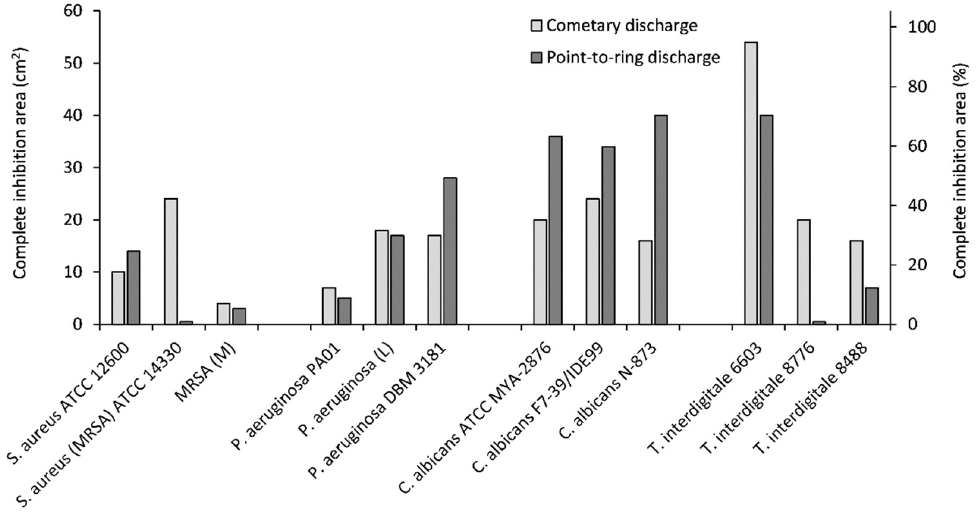
Figure 6. Areas of complete inhibition after exposure of individual microorganisms to the cometary/point-to-ring discharge for 60 min.